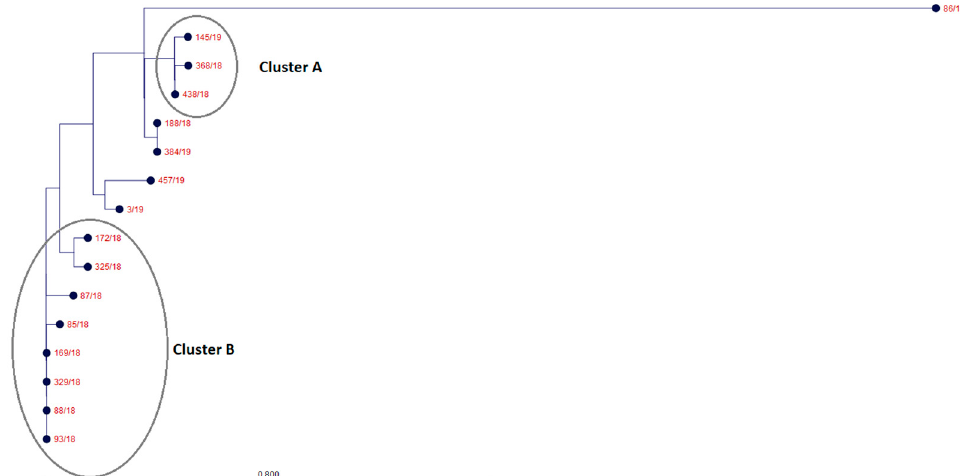
Figure 1. Phylogenetic tree based on the wg-SNP analysis. The dendrogram is limited only to the ST198 strains. The strain 86/18 was clearly distinct from all other isolates. Strains No. 145/19, 438/18 and 368/18 can be grouped as cluster A. Strains No. 85/18, 93/18, 88/18, 329/18, 169/18, 87/18, 172/18 and 325/18 can be grouped as cluster B.